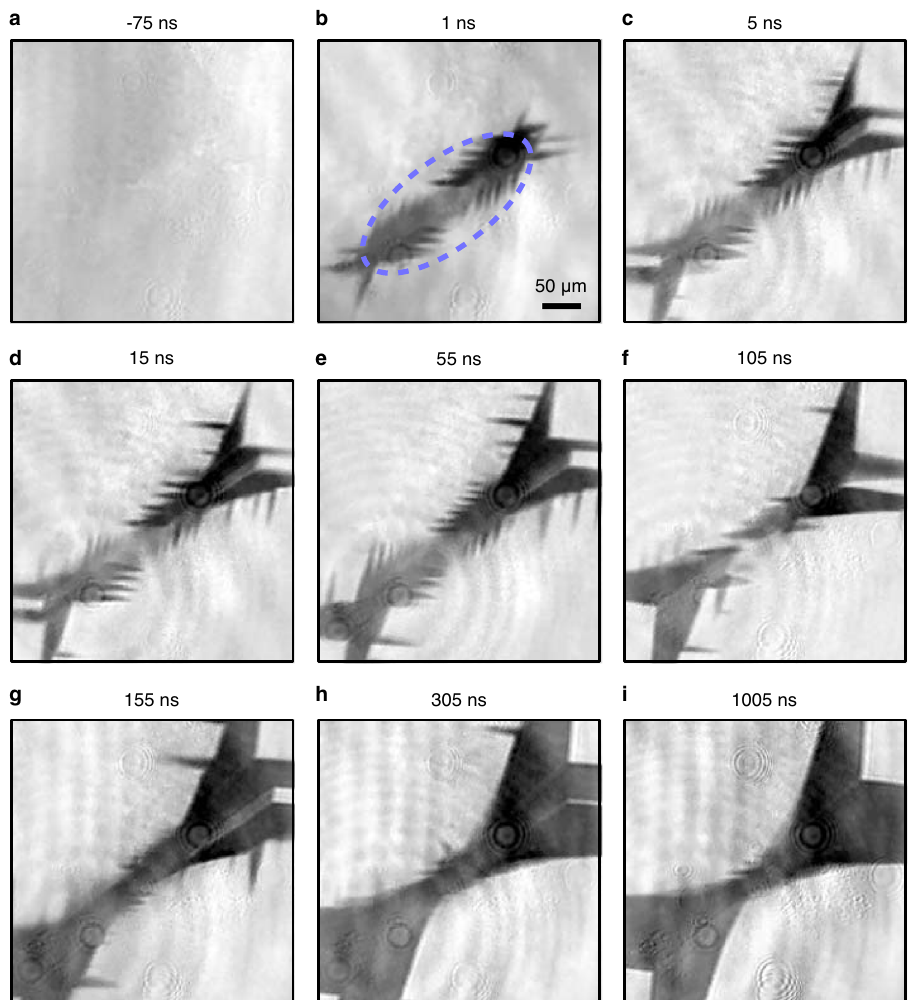
Fig. 2 | Time-resolved imaging of the pattern formation. a – i Representative background-subtracted magneto-optical images taken at the indicated times after the arrival of the pump pulse (wavelength 13 μ m, duration ≈ 2ps).The dashed blue